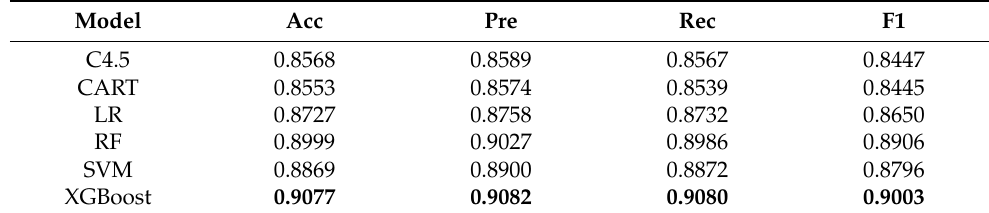
Table 5. Personalizing model for the three-level stress classification (mean of all).